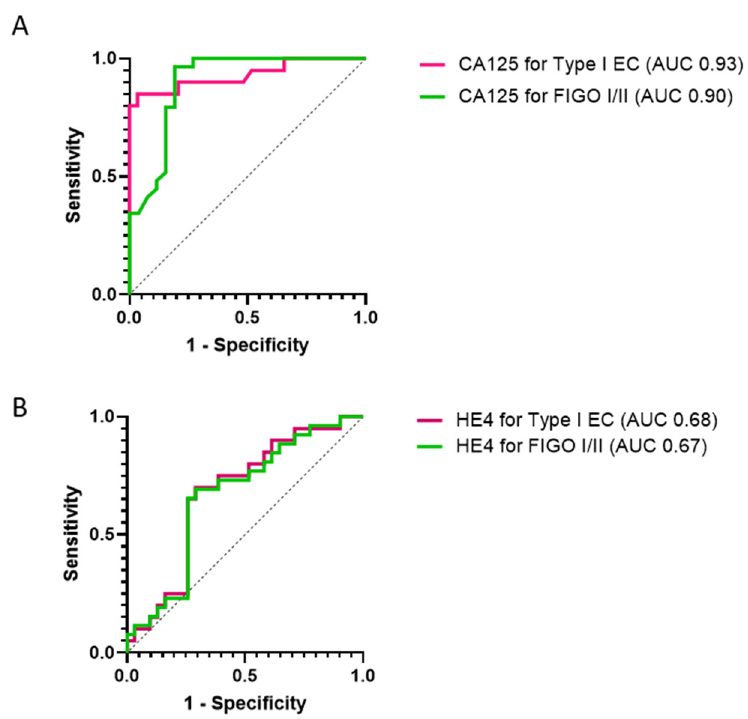
Figure 5. Receiver characteristic curve analyses indicating the performance of urine CA125 ( A ) and HE4 ( B ) for the detection of Type I and early-stage endometrial cancers. AUC: Area under the curve.